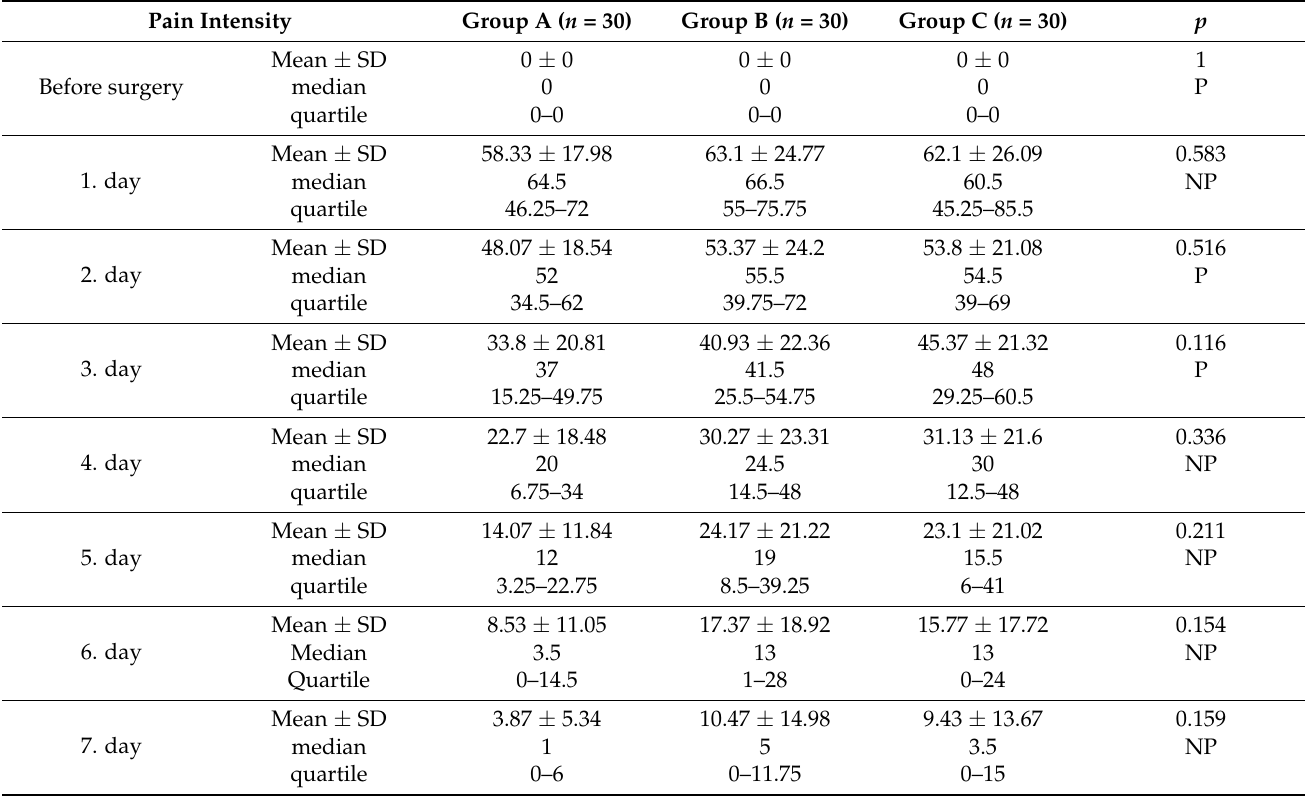
Table 3. Results of comparative analysis of pain intensity measured before surgery and on the following study days after surgery between groups A, B,